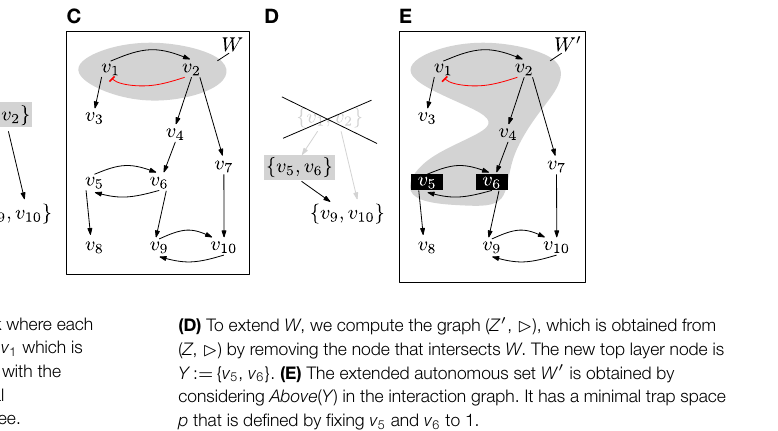
(D) To extend W , we compute the graph ( Z ′ , ◃ ), which is obtained from ( Z , ◃ ) by removing the node that intersects W . The new top layer node is Y : = { v 5 , v 6 }. (E) The extended autonomous set W ′ is obtained by considering Above ( Y ) in the interaction graph. It has a minimal trap space p that is defined by fixing v 5 and v 6 to